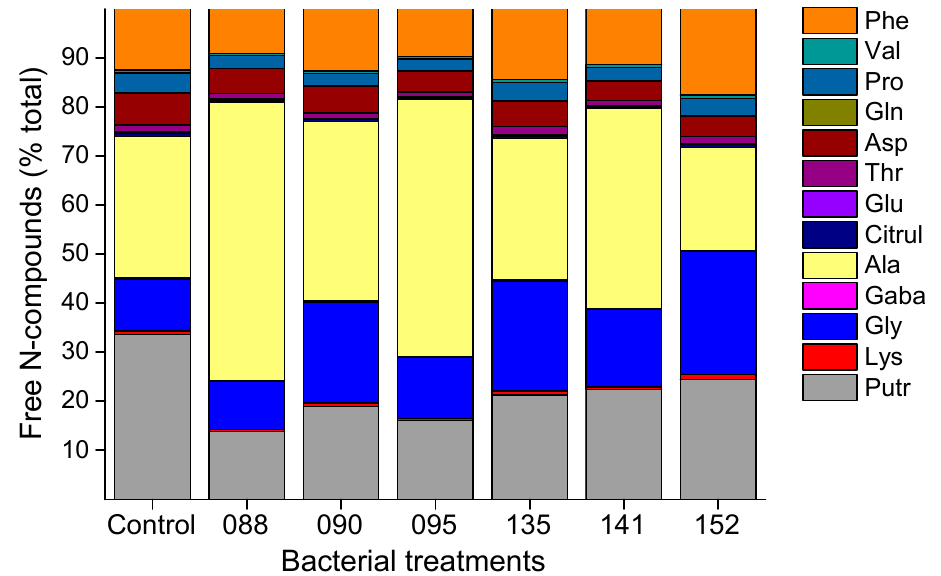
Figure 3. Main free amino acid and polyamine composition (% total) of leaves of sugarcane seedlings in function of the inoculation or not (Control) of six bacterial strains (IAC-BECa-088, IAC-BECa-090, IAC-BECa-095, IAC-BECa-135, IAC-BECa-141, IAC-BECa-152) 45 days after transplanting. * Phe, phenylalanine; Val, valine; Pro, Proline; Gln, glutamine; Asp, aspartate; Thr, threonine; Glu, glutamate; Citrul, citrulline; Ala, alanine; Gaba, gamma-aminobutyric acid; Gly, glycine; Lys, lysine; Putr, putrescine.